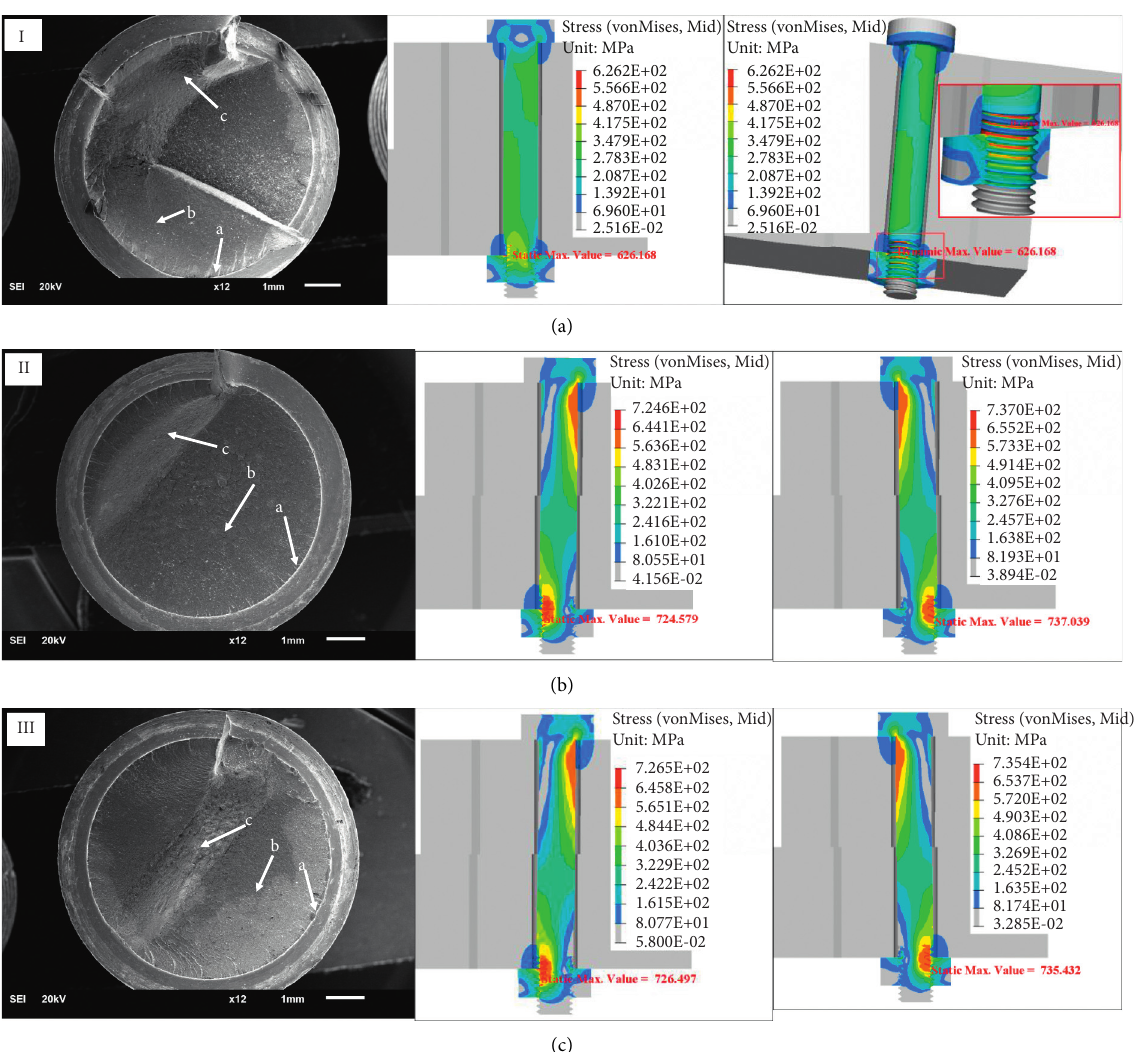
Figure 7: Comparison of macromorphology of bolt fracture and simulation stress: (a) Mode I, (b) Mode II, and (c) Mode